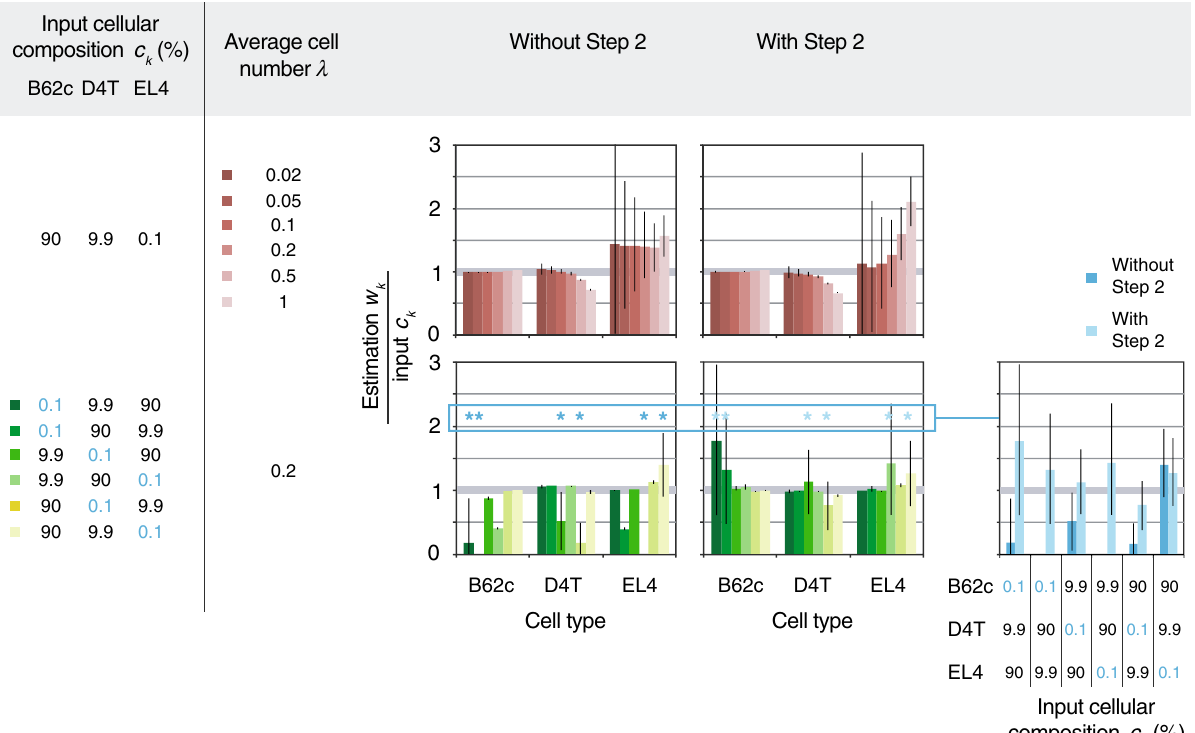
Figure 5. Computer simulation of the droplet assay provides insight into the effects of different input parameters on the accuracy and precision of the assay. Representative results from the simulation illustrating the effects of varying the average cell number per droplet λ and the cellular composition c . Three cell lines (B62c, D4T, and EL4) were assayed using the droplet RT-PCR platform to acquire empirical, real-world single-cell gene signature profiles and ambient RNA levels, which were used as input reference profiles and ambient RNA levels ( r and n ) for the simulation. The bar graphs show predictions made with or without implementing Step 2 of the deconvolution model (means of n = 1000 trials, error bars represent the 95% confidence intervals). As expected, an increase in λ (red bar graphs) resulted in higher precision of our predictions, as evidenced by the reduced error bars. The accuracy was improved by incorporating Step 2, which corrected for ambient RNA and duplets, but only when λ ≤ 0.2. When varying cellular compositions (green bar graphs), an improvement in accuracy was also observed when Step 2 was applied, whereas the rarest populations (marked by asterisks and plotted separately in the blue bar graph for better comparison) were often undetected without this correction